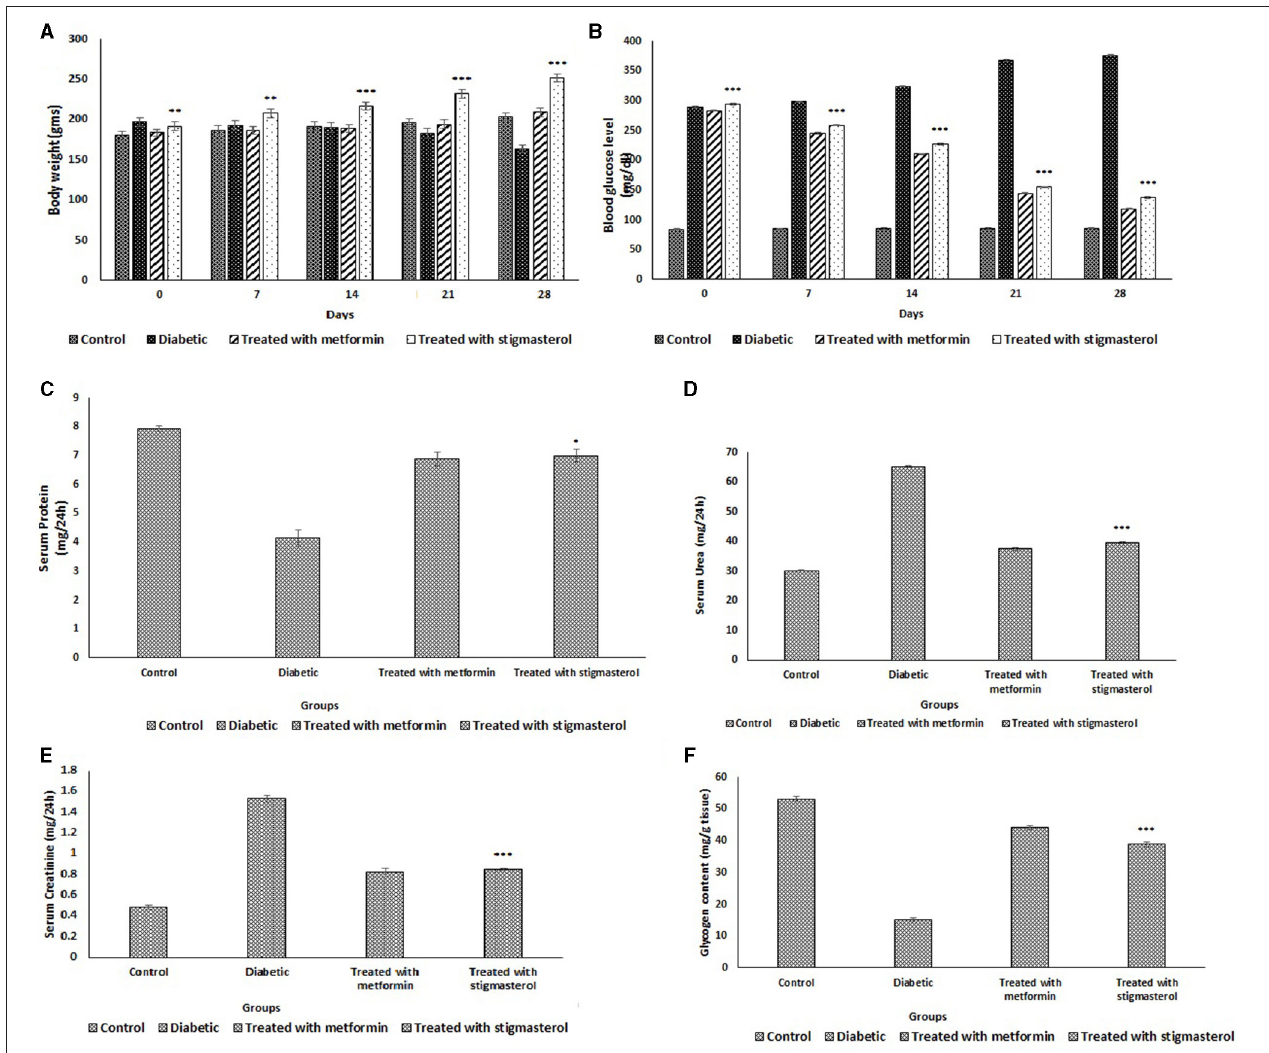
FIGURE 4 | Effect of stigmasterol on rats (A) body weight (g), (B) blood glucose level (mg/dL), (C) serum protein (mg/24h), (D) serum urea (mg/24h), (E) serum creatinine (mg/24h), and (F) glycogen content in control and diabetic rats. Number of animals used n = 10, error bars indicate standard deviations, significance * P < 0.05, ** P < 0.01, and *** P <